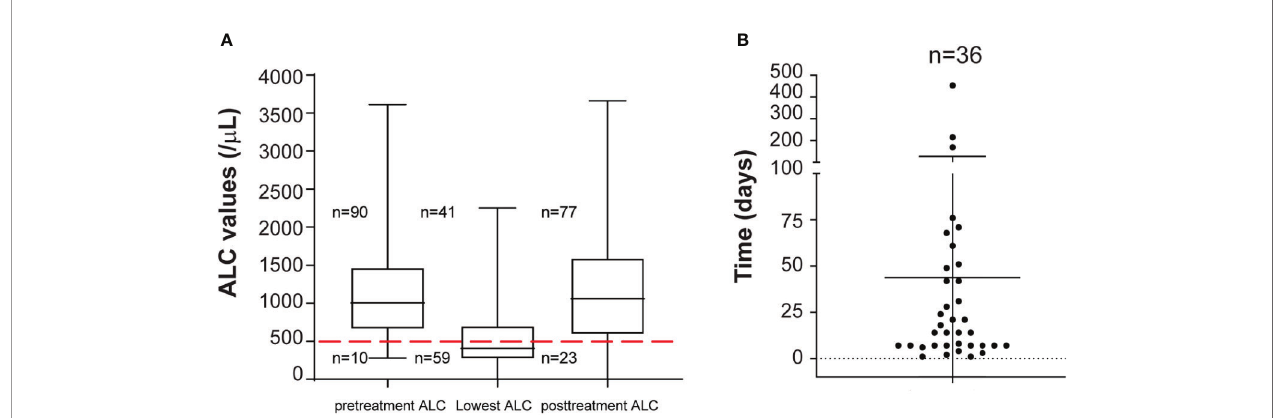
FIGURE 2 | (A) ALC recovery kinetics in patients with severe lymphopenia. Pretreatment ALC, lowest ALC and ALC at completion of daratumumab therapy (posttreatment ALC) for all patients (n = 100) are shown. Median and range are plotted. Red dashed line is set at 500 lymphocytes/ m l. 10, 59, and 23 patients out of 100 had severe lymphopenia pretreatment, at nadir, and at completion of daratumumab therapy. (B) Time to ALC recovery. Patients with ALC recovery above 500 lymphocytes/ m l (n = 36) from lowest ALC are shown. Time is in